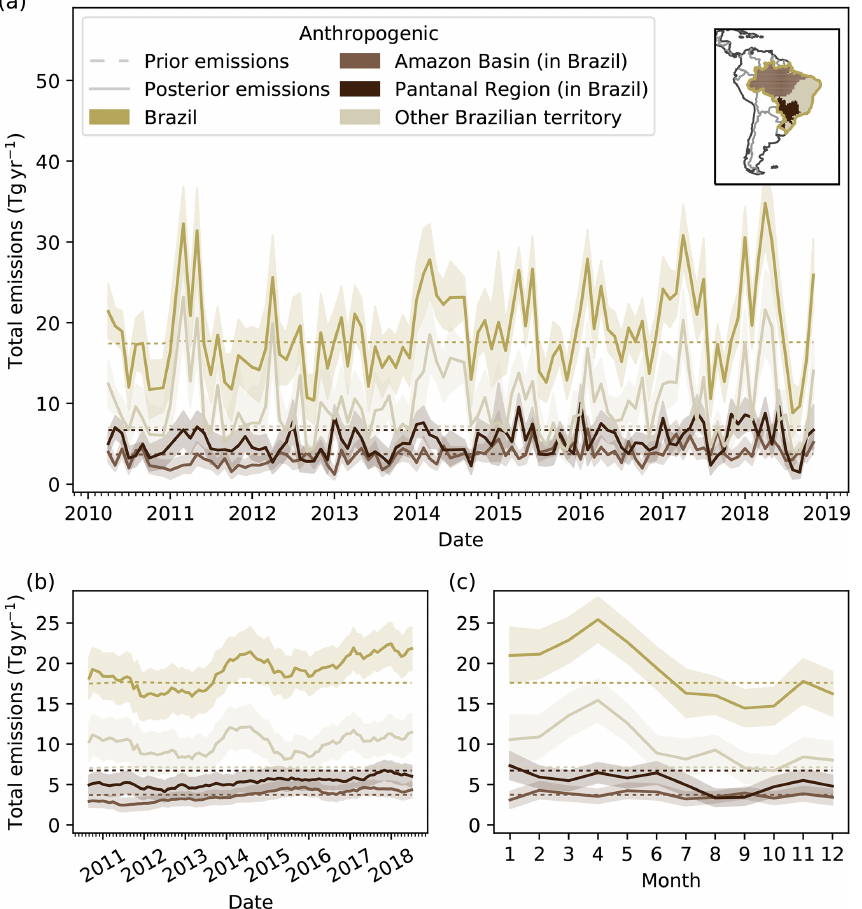
Figure 6. Brazil’s anthropogenic emissions aggregated over the Amazon basin, Pantanal region and the rest of Brazilian territory. (a) Monthly emissions with an inset map showing the masks used to delineate different regions; (b) monthly emissions smoothed with a 12-month rolling mean and (c) seasonal means across the 2010 to 2018 period. Errors for mean values assume a 50% correlation between individual